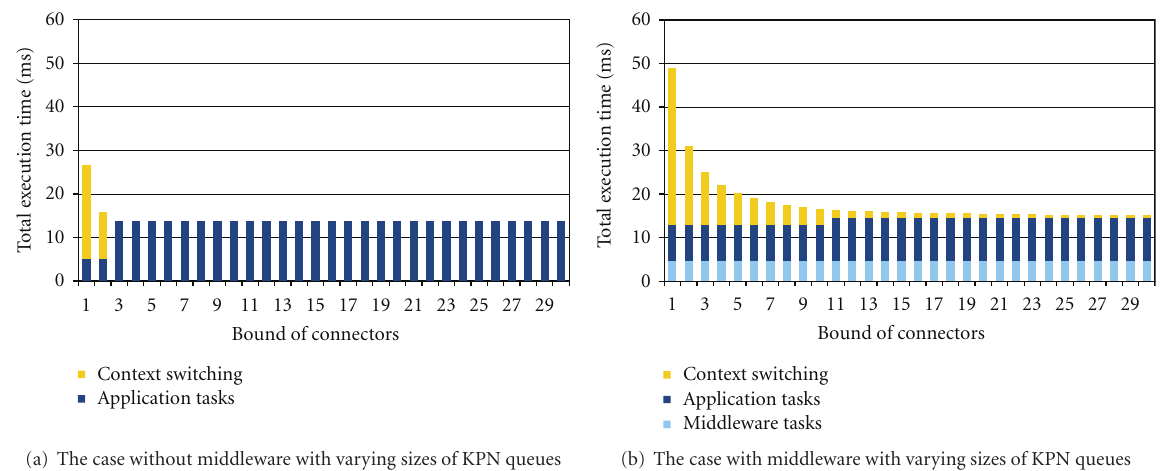
Figure 9: The distribution of total execution time between application tasks, middleware tasks, and context switching for the JPEG encoder/decoder case study.